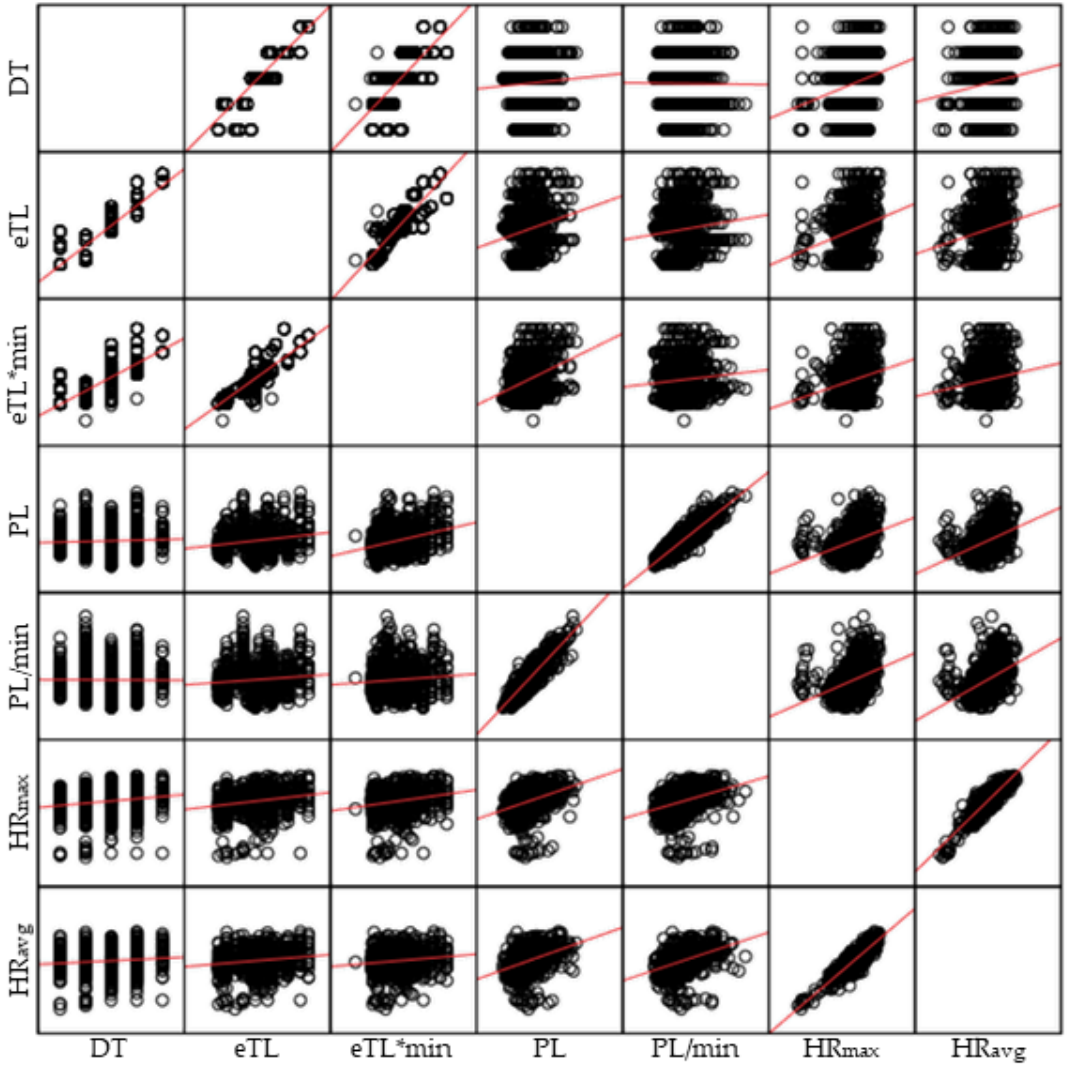
Figure 3. Matrix scatter plots between the intensities studied (in pairs) in the interventions. Note: eTL = External Intensity; TD = Task Density; PL = Player Load; min = Minute; iTL = Internal Intensity; HR = Heart Rate; avg = Average; max = Maximum.